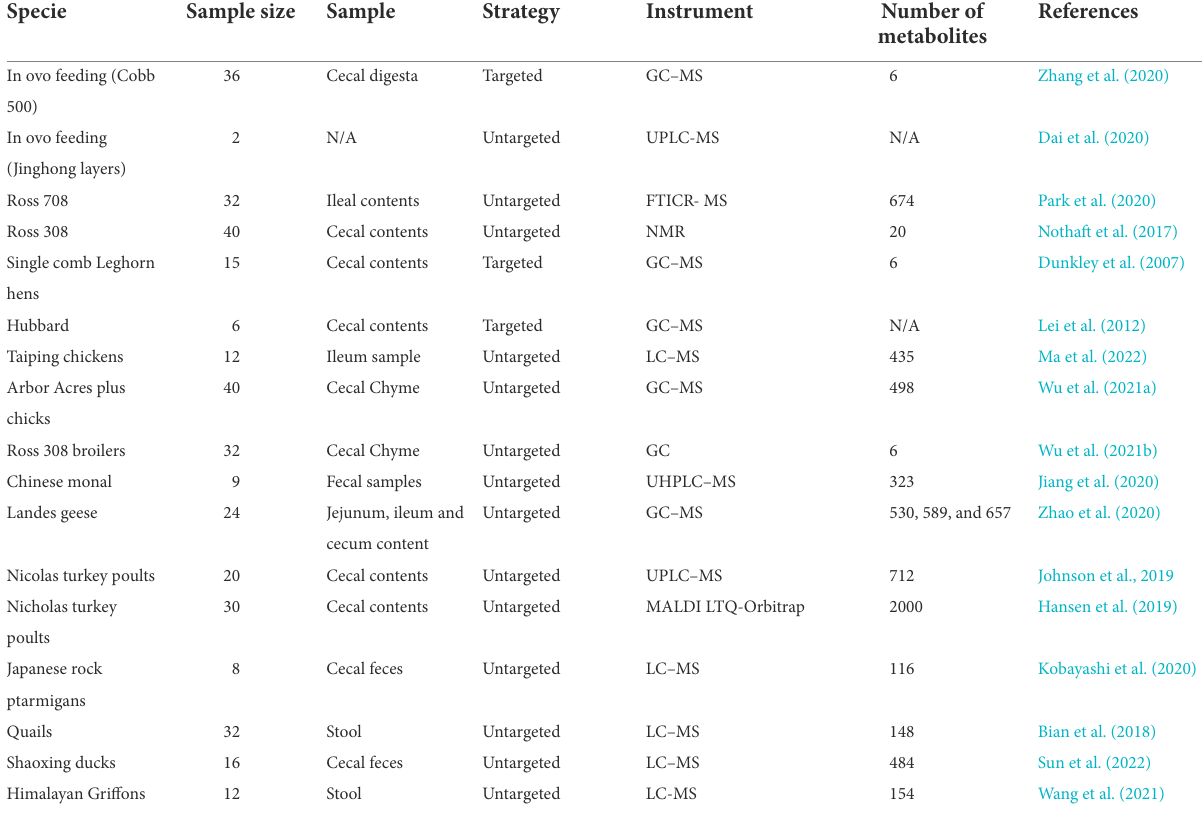
TABLE 7 Studies involving intestinal metabolomics in